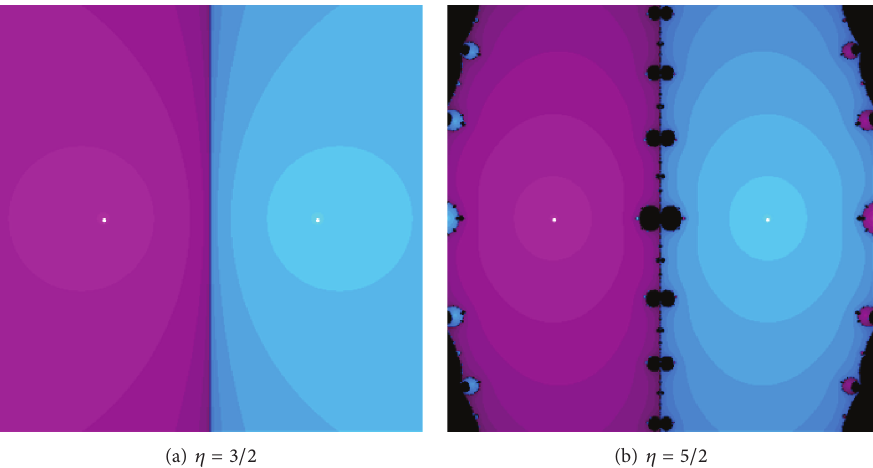
Figure 3: Basins of attraction for different methods of family (14) for 𝑓(𝑥) = 𝑥 2 − 1 shaded according to the number of iterations.